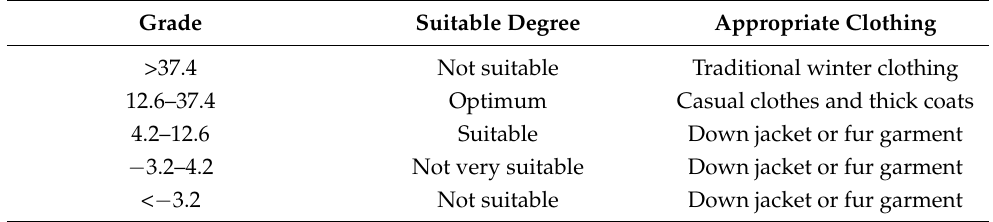
Table 4. Grading standard of the ISTSI